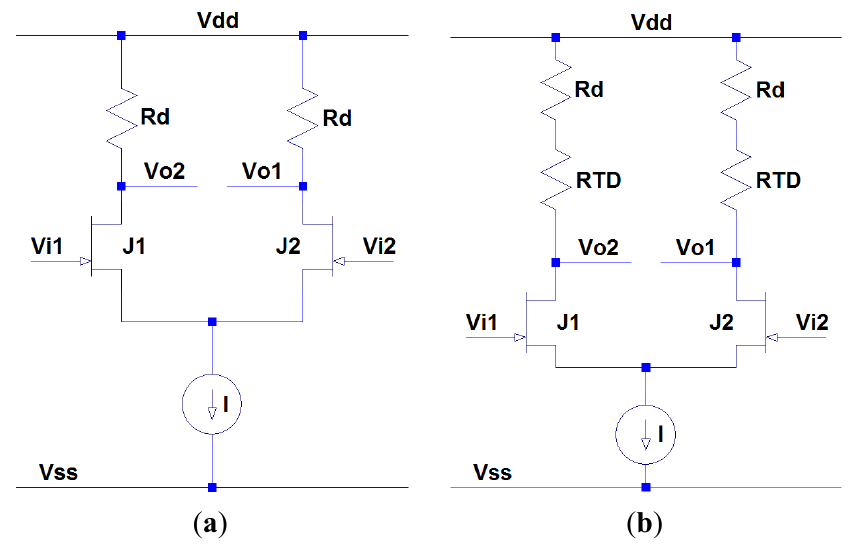
Figure 5. ( a ) Classic resistive load JFET differential amplifier. ( b ) Modified JFET differential amplifier with additional RTD elements for temperature compensation.